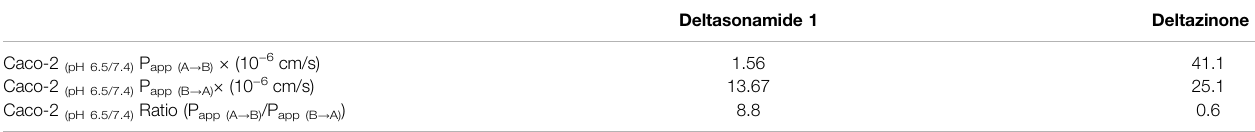
TABLE 1 | Caco-2 cellular permeability values for Deltasonamide 1 and Deltazinone